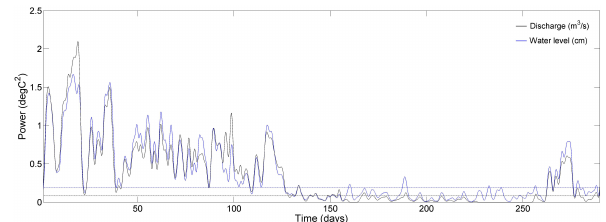
Fig. 4. Comparison of the wavelet analysis output (scale-averaged power spectrum over 24h scale) between discharge (black line) and water-level time series (blue line) at site 7 (Los Crespos station). Dashed black and blue lines indicate the corresponding 95% con- fidence levels for the red-noise spectrum for discharge and water- level time series,